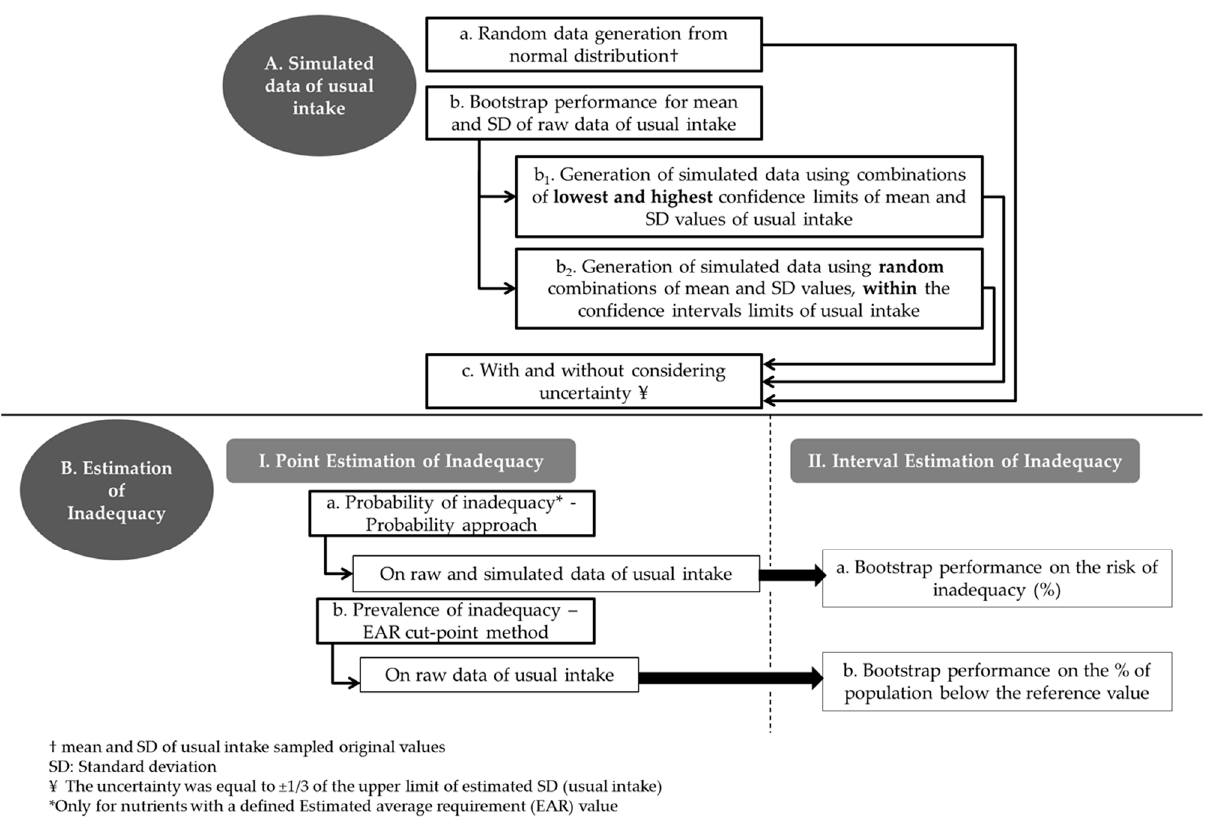
Figure 1. Methodological design for the generation of simulated data of the usual intake ( A ) and the estimation of inadequacy in the studied population ( B ).